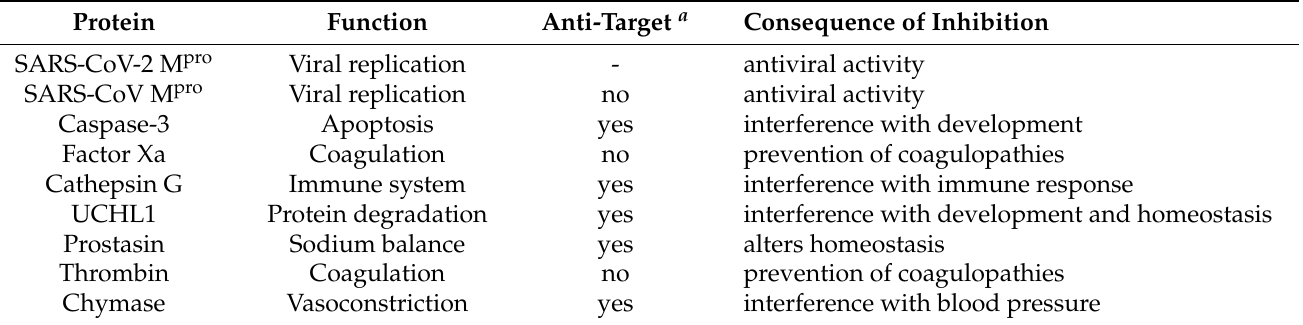
Table 1. Proteins considered in this